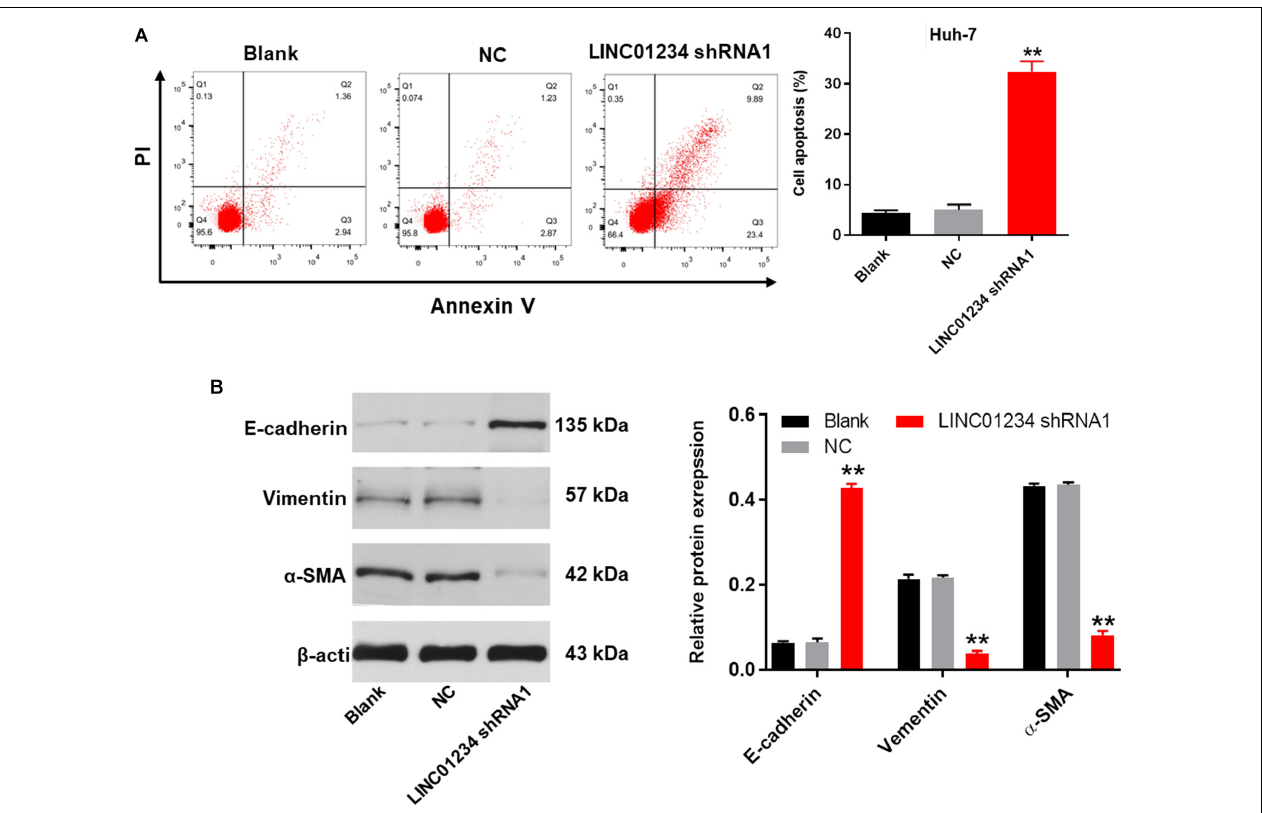
FIGURE 4 | Knockdown of LINC01234 significantly suppressed the progression of liver cancer in vitro . (A) The apoptotic Huh-7 cells were examined by flow cytometry. (B) Cell migration was measured by wound healing assay. (C) Cell invasion was detected by transwell assay. (D) The protein expressions of E-cadherin, vimentin and α -SMA in Huh-7 cells were detected by western blot. The relative protein expressions were quantified by normalizing to β -actin. ** P < 0.01 compared to